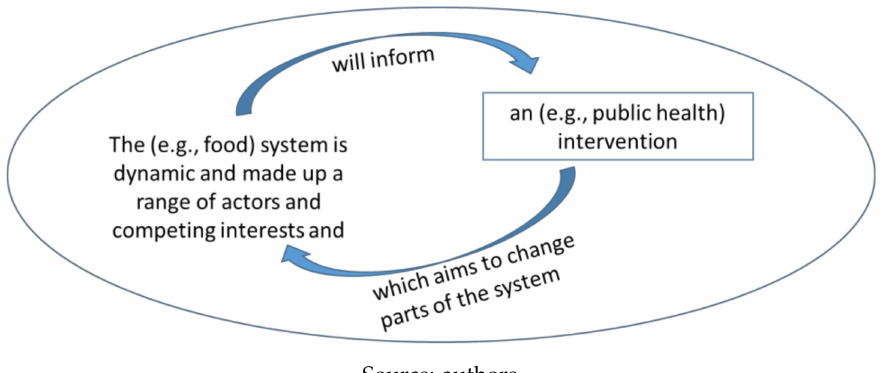
Figure 2. A systems perspective on interventions, where the intervention is also part of the